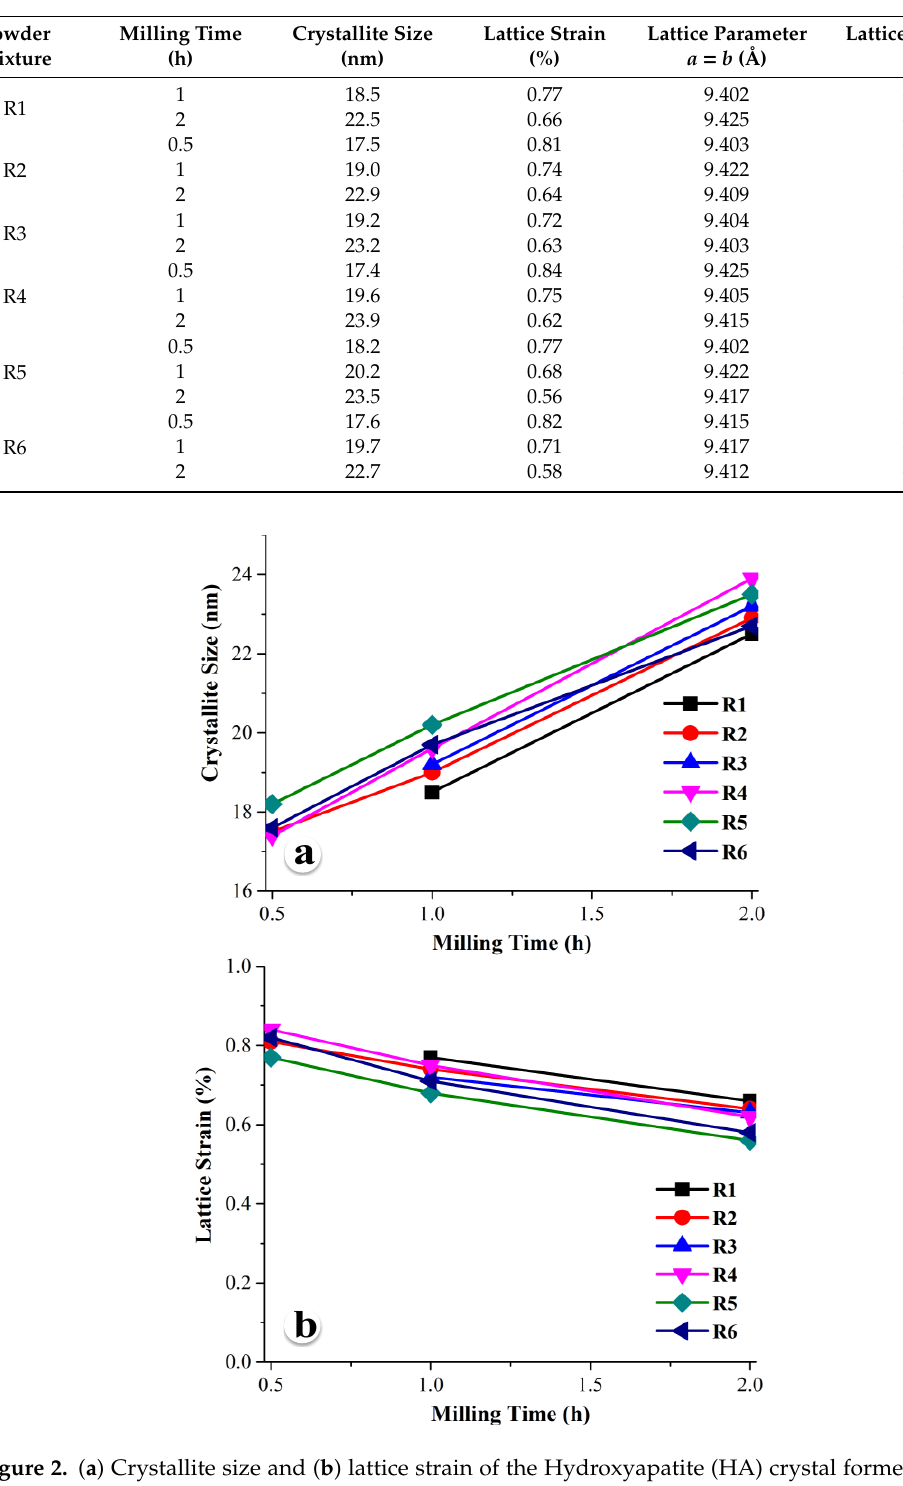
Table 2. Crystallite size, lattice strain, and lattice parameters of the hydroxyapatite (HA) crystal formed after different times of ball milling.